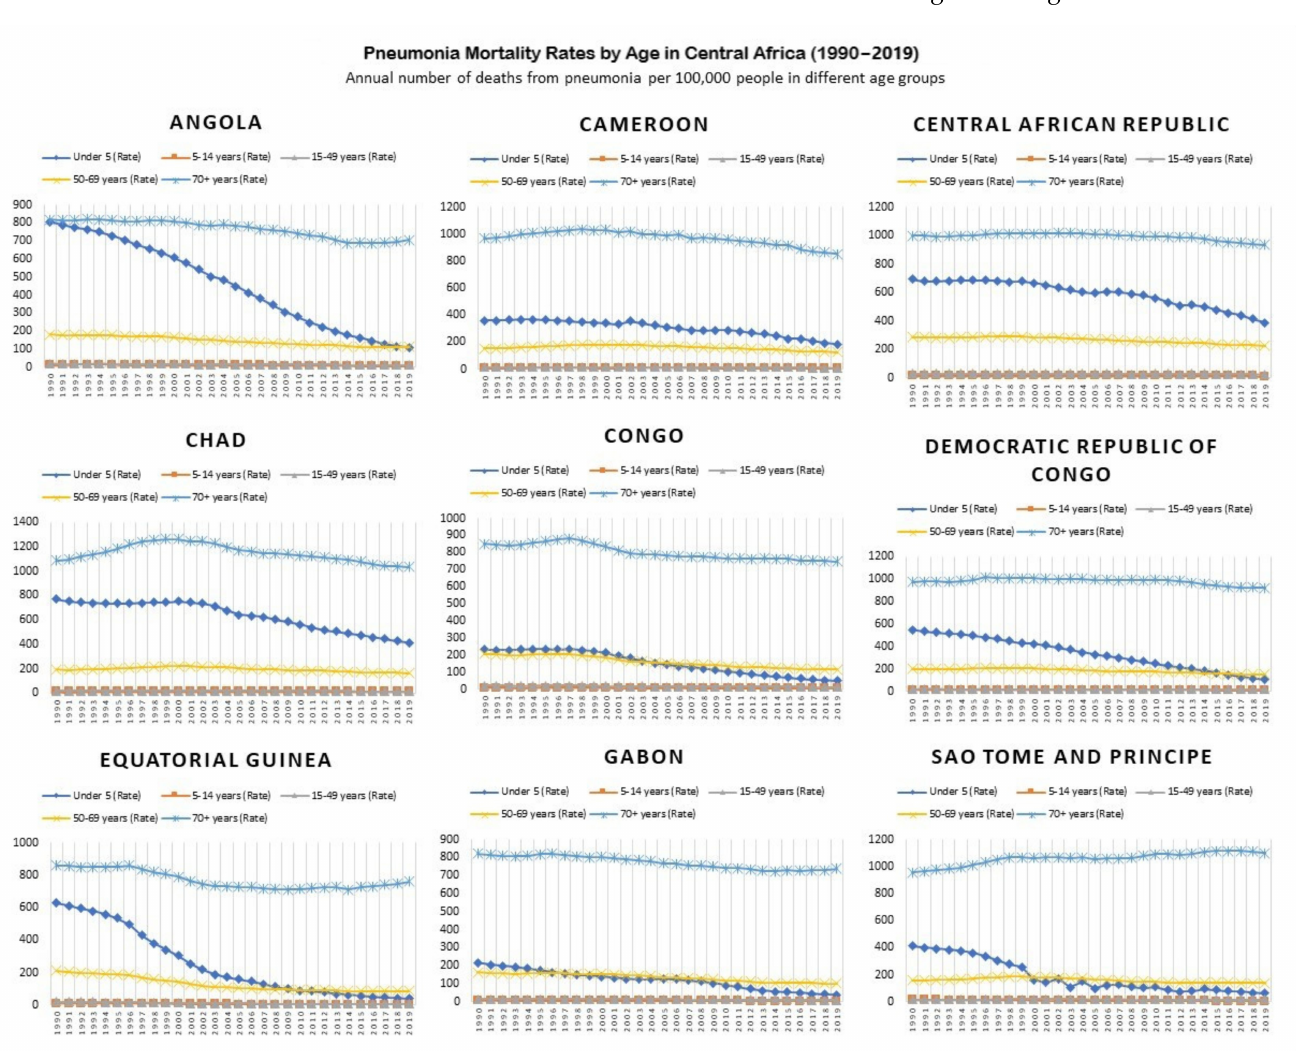
Figure 7. Pneumonia mortality rates in Central Africa between 1990 and 2019 are presented as the annual number of deaths from pneumonia per 100,000 people in different age